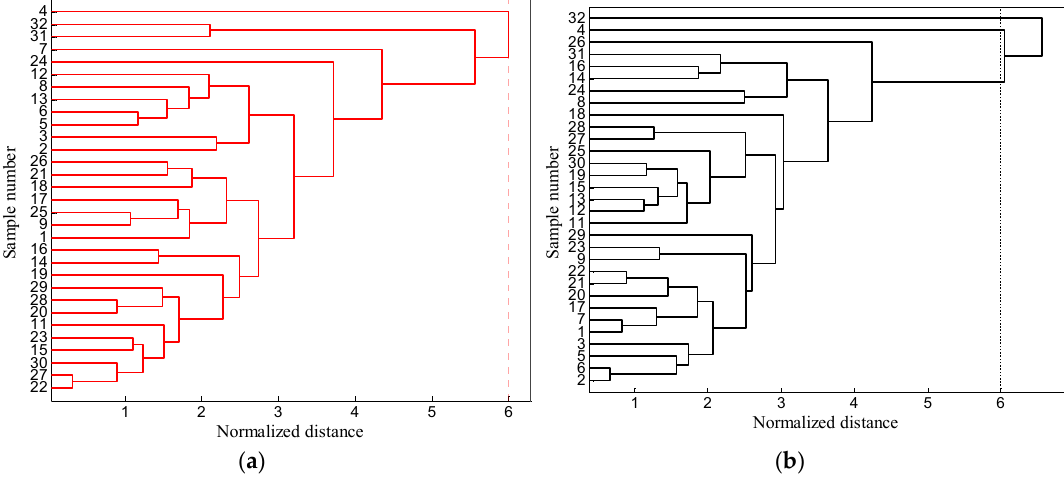
Figure 14. Clustering tree. ( a ) Clustering tree before vibration test; ( b ) Clustering tree after vibration test.